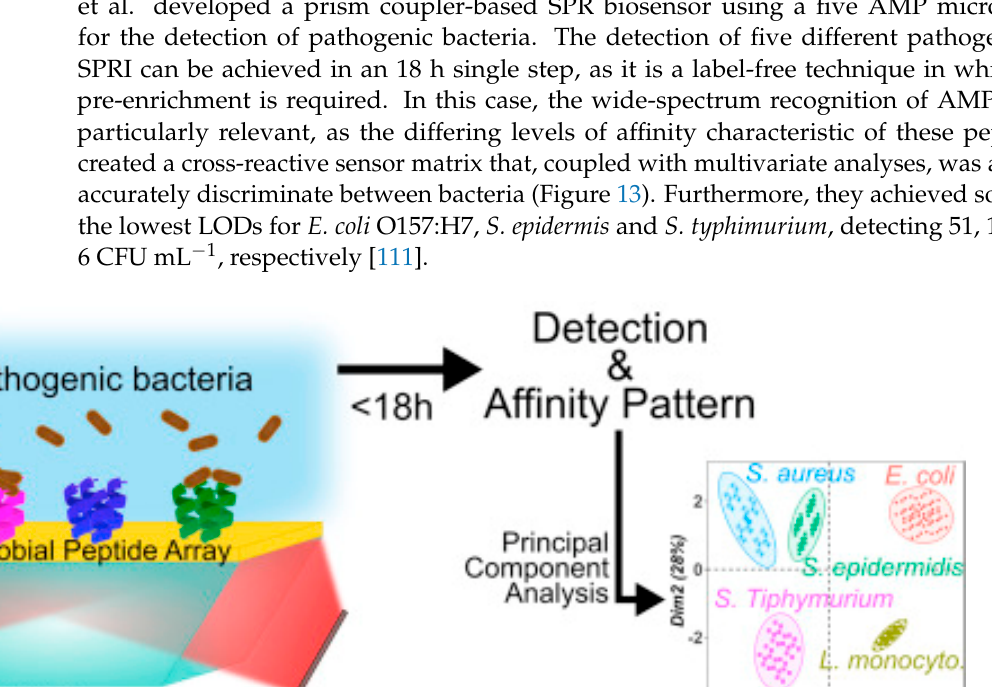
Figure 14. Schematic illustration of optical fiber SPR detection of E. coli O157:H7 [114]. Copyright 2018, Elsevier.